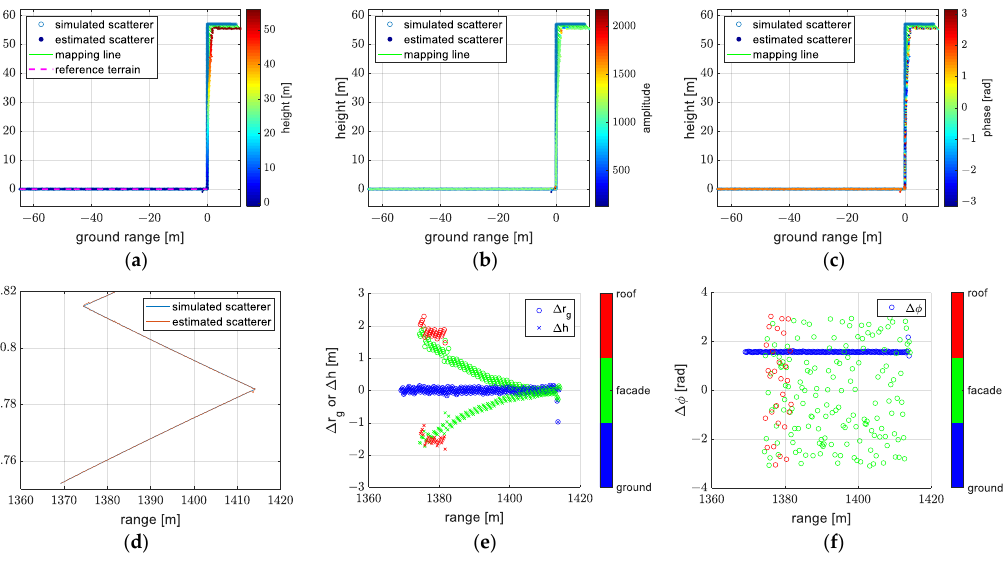
Figure 10. The reconstruction obtained using model 1 (the exact form of the planar wavefront model): ( a ) reconstruction with colors denoted as height, ( b ) reconstruction with colors denoted as amplitude, ( c ) reconstruction with colors denoted as phase, ( d ) the off-nadir angle of the reconstruction, ( e ) the error of the ground range and height, ( f ) the error of the phase.